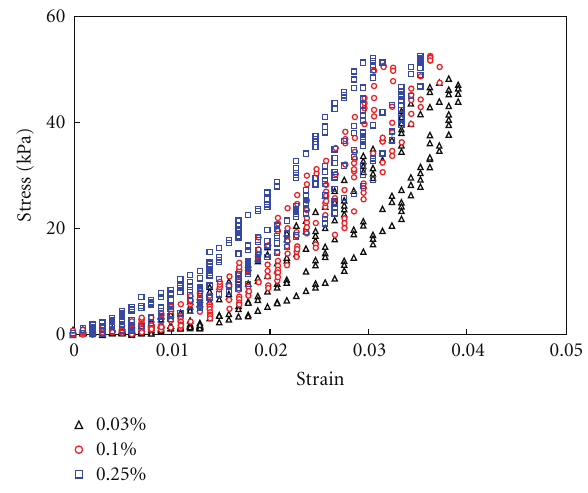
Figure 3: Representative stress-strain responses of collagen scaf- folds crosslinked with 0.03%, 0.1%, and 0.25% GP subjected to equibiaxial tensile test. The maximum load is 70 g, 100 g, and 100 g for 0.03%, 0.1%, and 0.25% GP crosslinked samples, respectively.